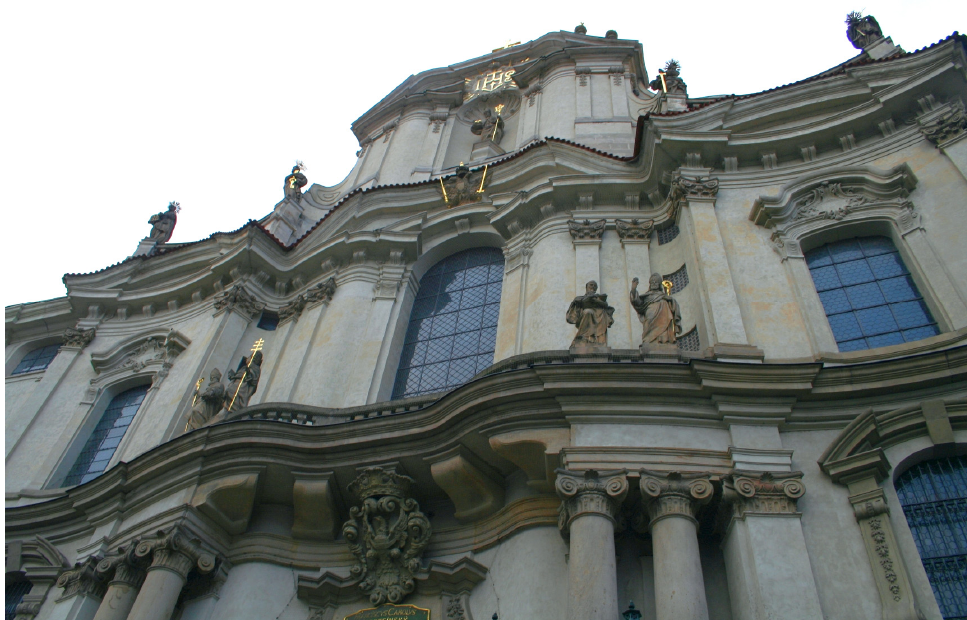
Figure 7. Strongly embattled entablature in the works of Christoph and Kilian Ignaz Dientzenhofer. Facade maintained in almost monochromatic colors with elements of various materials: stone and stucco. Facades of the churches of St. Nicholas on Mala Strana of Prague. Photo author.